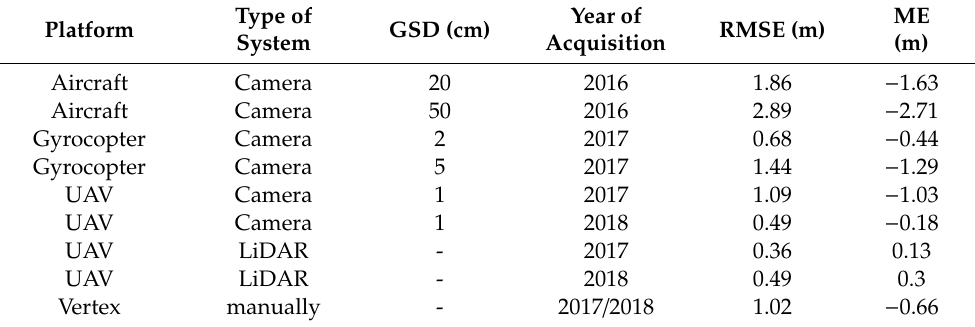
Table 3. Overview of the statistical results of the remote sensing datasets and the measurements via Vertex. Tree heights recorded via measuring tape were assumed as the real tree heights.